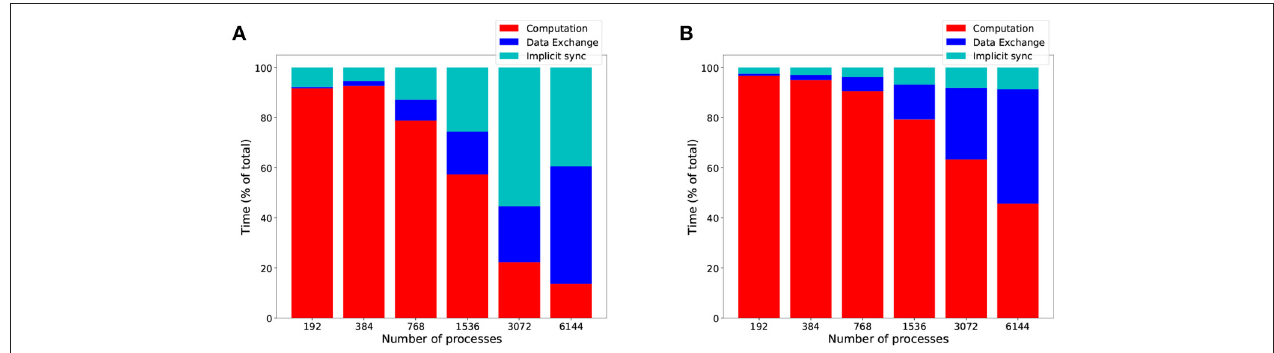
FIGURE 11 | HP-NBX computational efficiency gains over the baseline Round robin-PEX during MVC simulations . The graph shows the proportion of time an MVC simulation spends in computation (red), implicit synchronization (light blue), and data exchange (dark blue) when using Round robin-PEX (A) and HP-NBX (B) . The proposed strategy HP-NBX consistently increases computational efficiency in all processes counts (percentage points improvement in increasing process count order: 5.2, 2.7, 12, 22.3, 40.8, and